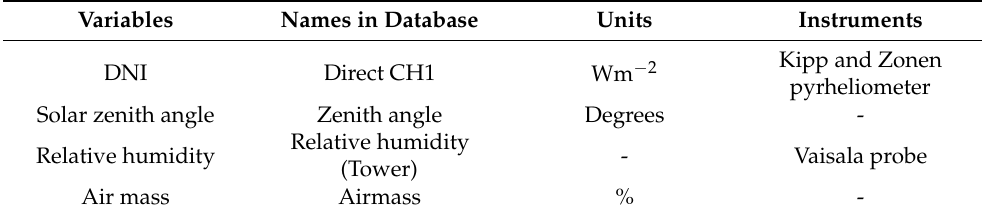
Table 1. The details of meteorological variables in the open database. Variables Names in Database Units Instruments Kipp and Zonen DNI Direct CH1 Wm − 2 pyrheliometer Solar zenith angle Zenith angle Degrees - Relative humidity - Vaisala probe Relative humidity (Tower) Air mass Airmass